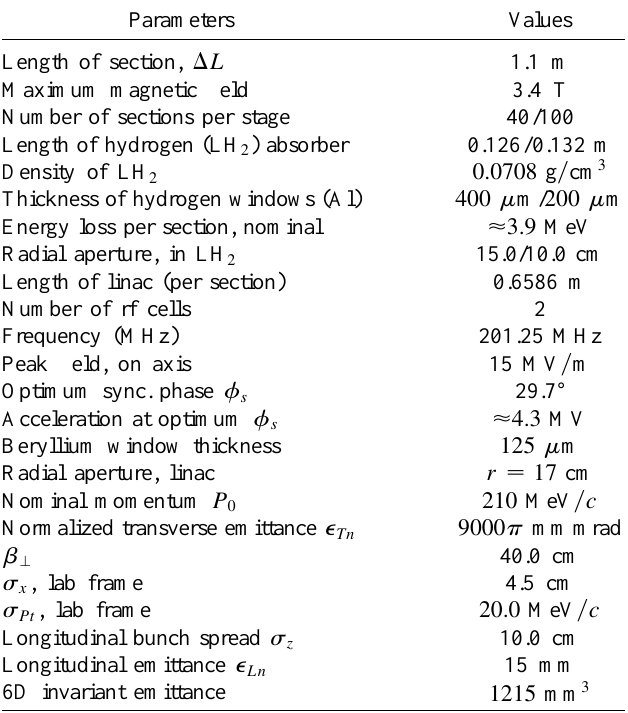
TABLE I. List of parameters for the 3.4 T FOFO.